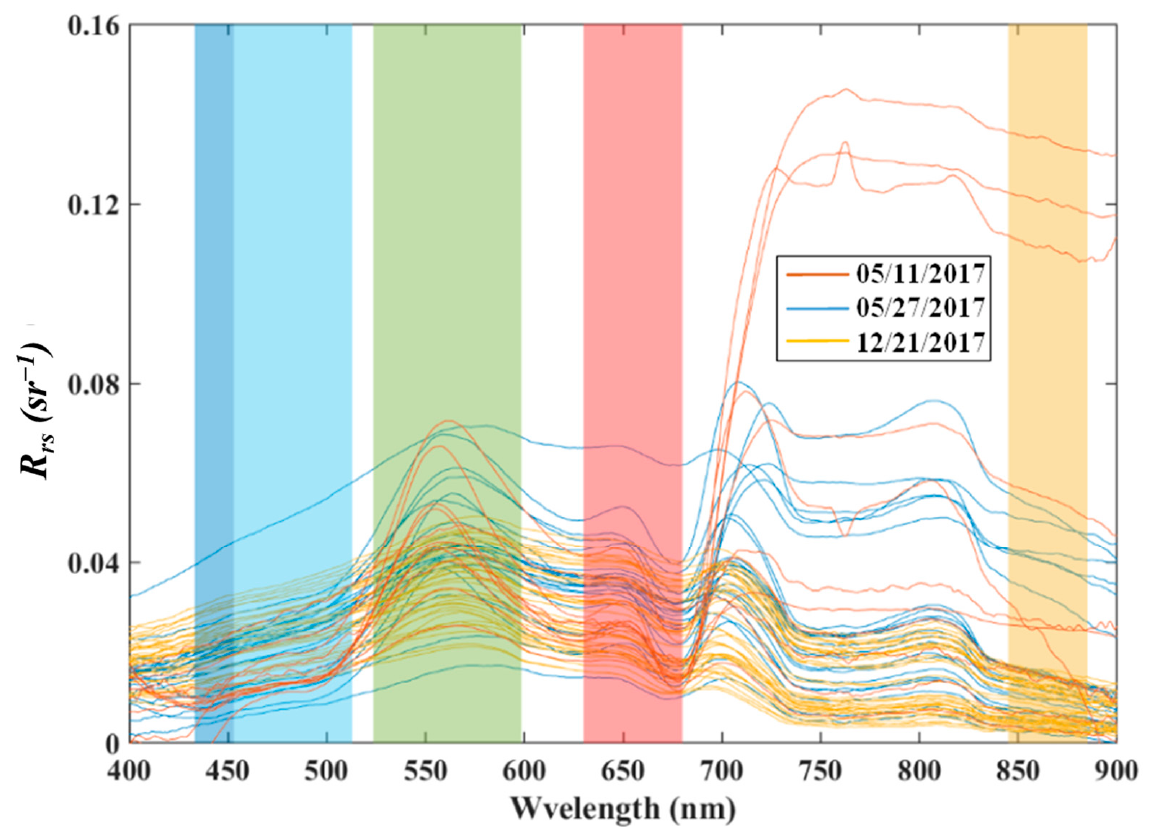
Figure 3. Measured remote sensing reflectance ( R rs ) from Lake Taihu (dates: 11 May 2017, 27 May 2017, and 21 December 2017). The line color represents different sampling dates. The color column represents the wavelength range of each band of OLI (Deep blue: 443 nm band, Light blue: 483 nm band, Green: 561 nm band, Red: 655 nm band, Yellow: 865 nm band).